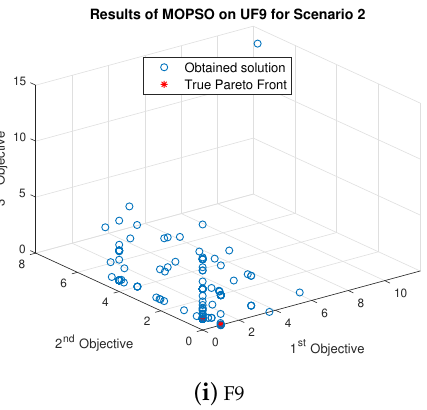
Figure 11. Results of MOPSO for Scenario